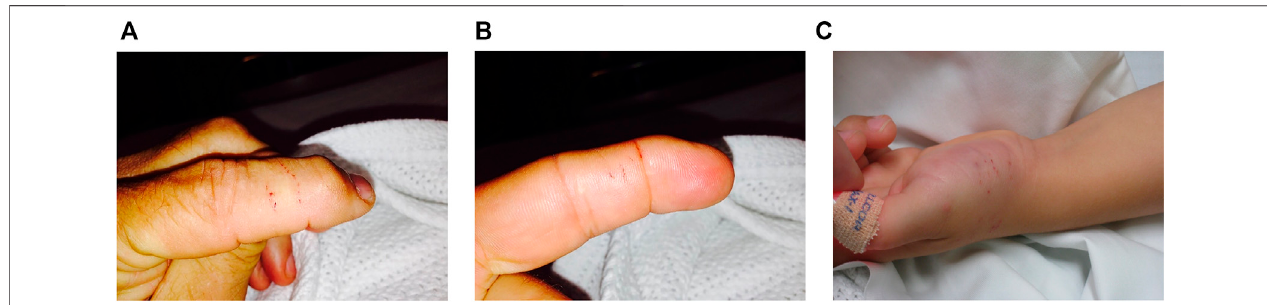
FIGURE 3 | ( A – C) : Fang marks of patients bitten by sea snakes.